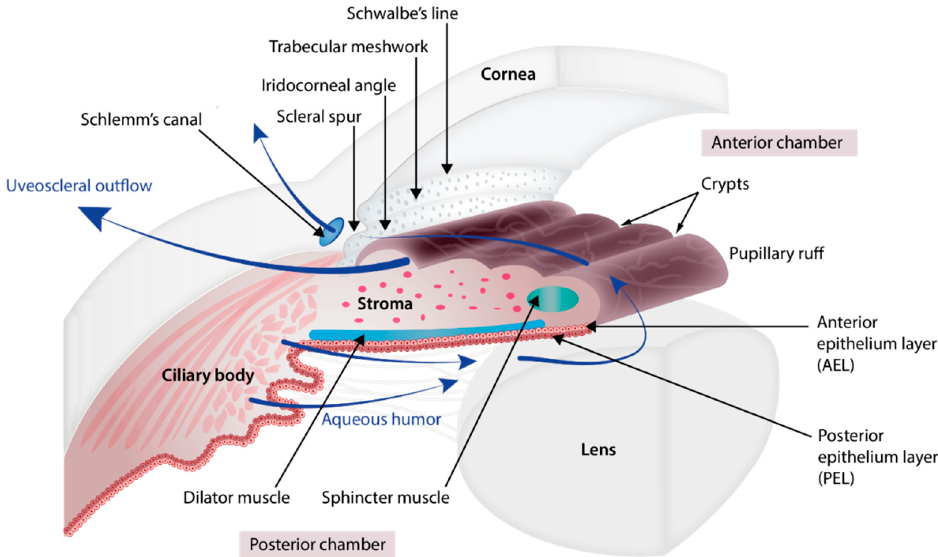
Figure 2. Anatomy of the iris, ciliary body, and aqueous humor pathway. The iris is organized into four layers (from the visible surface layer to the posterior region next to the lens): anterior border layer, stroma, and sphincter muscle, the lightly pigmented anterior epithelium layer (AEL) and dilator muscle, and the heavily pigmented posterior epithelium layer (PEL). The circular sphincter muscle lies within the stroma. The anterior iris epithelium is composed of a single layer of myoepithelial cells. The basal portion of these cells consists in elongated smooth muscle processes forming 3 to 5 layers of radial dilator muscle fibers. The iris root is attached to the ciliary body and to the corneoscleral junction (iridocorneal angle). Near the root, the anterior border layer, stroma, and bilayer epithelium of the iris form finger-shaped processes and become the ciliary body, the anterior and posterior epithelium layers of which are heavily and lightly pigmented, respectively. The aqueous humor that provides nourishment to eye structures is produced by the ciliary body. It flows between the iris and lens, through the pupil, and to the anterior part of the iris, where it runs (i) across the iris and anterior face of the ciliary body, and out through the sclera (uveoscleral pathway) and (ii) through the trabecular meshwork (at the corneoscleral junction with the iris periphery) and out along the inner wall of Schlemm’s canal.